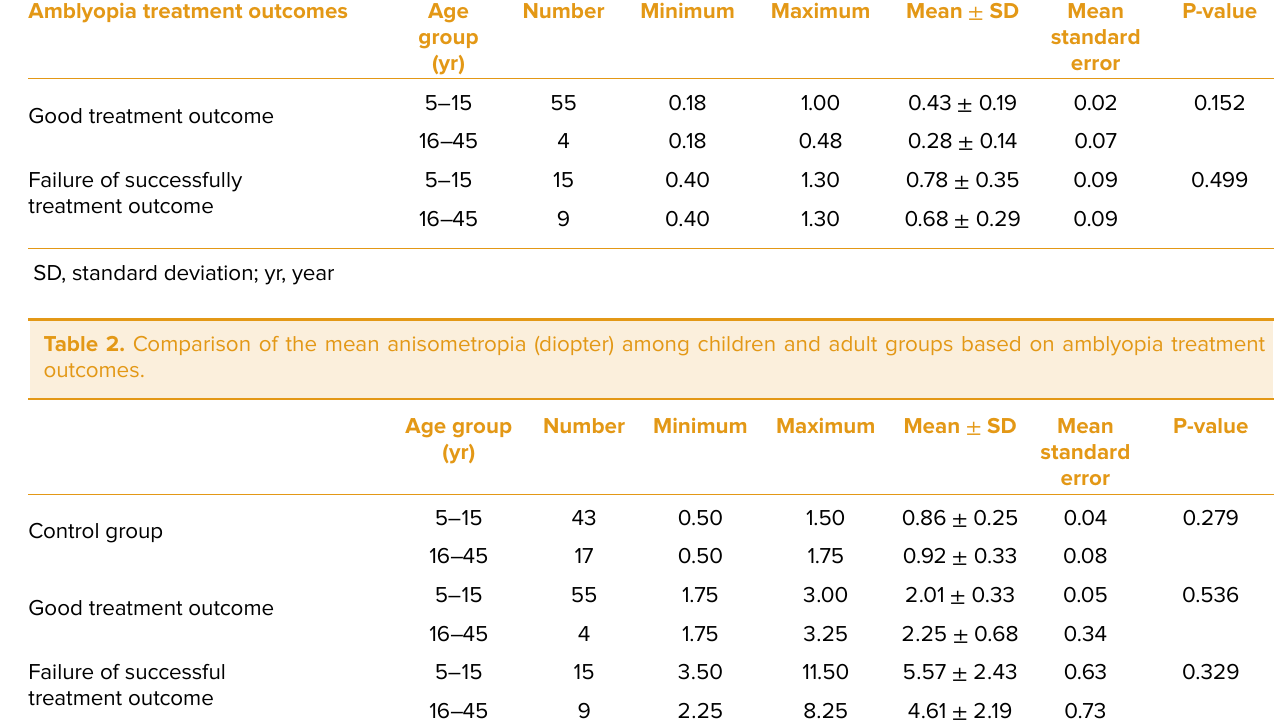
Good treatment outcome